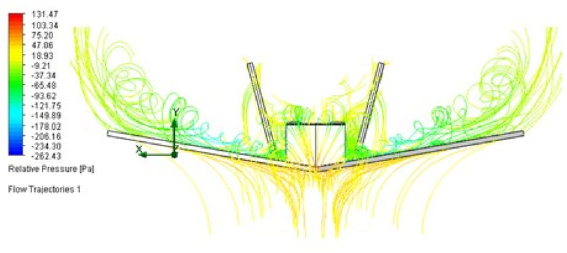
Figure 23. Flow trajectories with relative pressures.